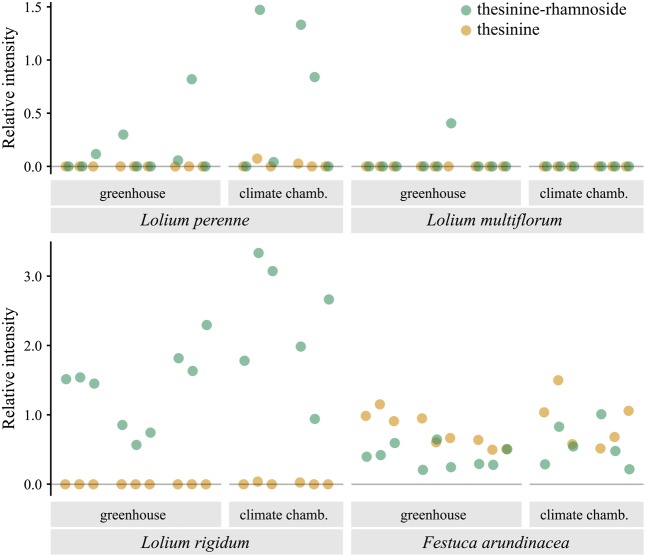
Occurrence of thesinine-rhamnoside and thesinine in individual samples of L. perenne, L. multiflorum, L. rigidum, and F. arundinacea. Intensities extracted from LC-MS data for thesinine-rhamnoside (m/z 434.2, 324 s, green) and thesinine (m/z 288.1, 340 s, orange) displayed relative to the intensity of an internal standard (retrorsine, 0.375 μg/ml). Samples are grouped according the place in which the grass plants were grown and the growth stage at sampling (2, 6, and 8 weeks after germination).